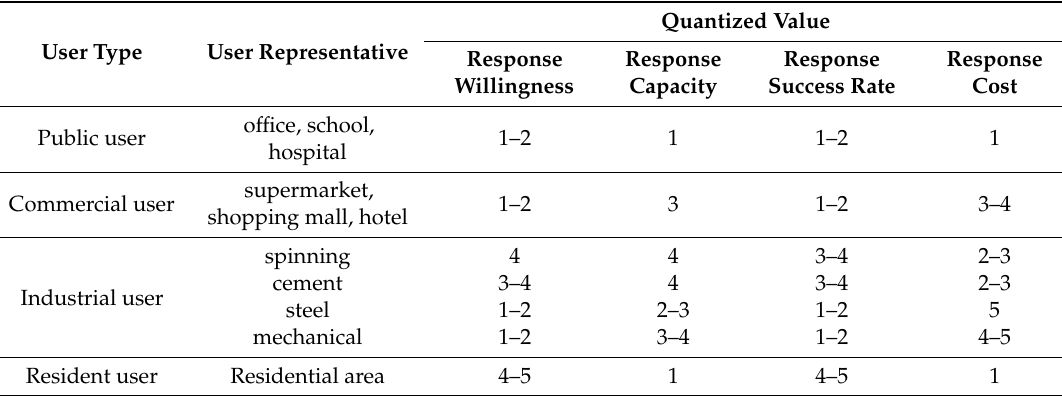
Table 7. The rule of quantifying users’ response